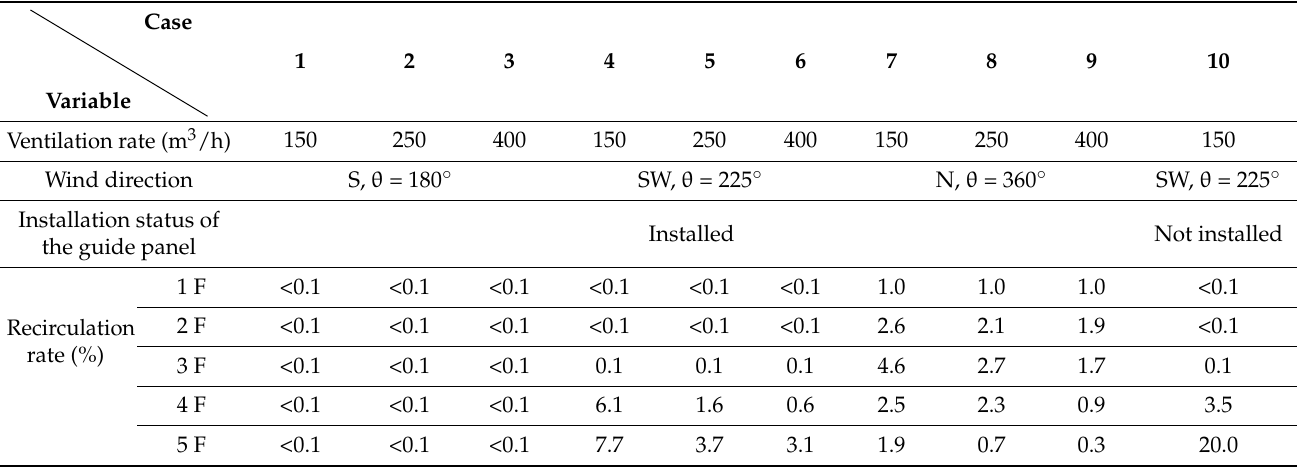
Table 2. Exhaust air recirculation rate on each floor by